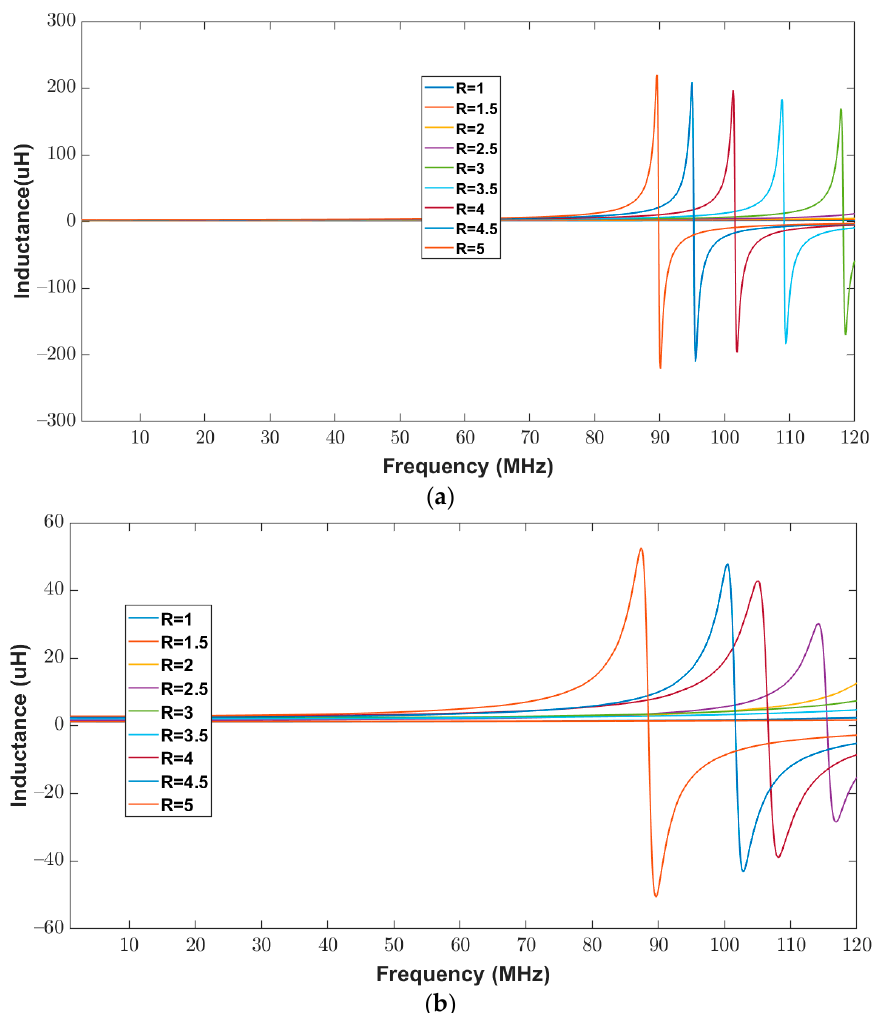
Figure 12. Inductance of elliptical planar inductors for the full range of frequencies from 20 Hz to 120 MHz with varying major-to-minor ratio values while trace separation ( S ) and trace width ( W ) were kept constant at 200 μ m ( a ) Computed response using proposed model ( b ) Measured response from the impedance analyzer.